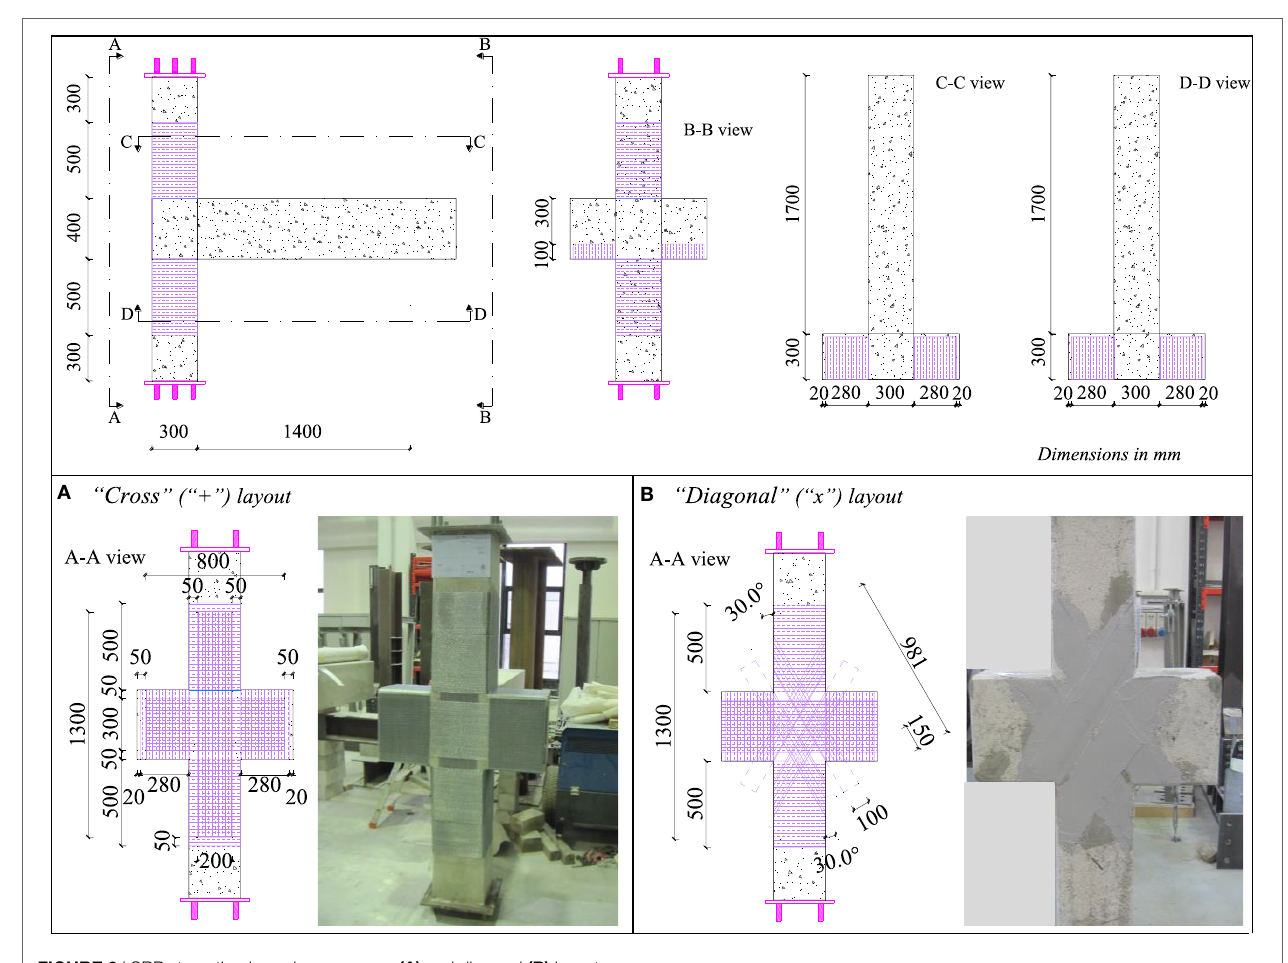
FIGURE 3 | SRP strengthening schemes: cross (A) and diagonal (B)